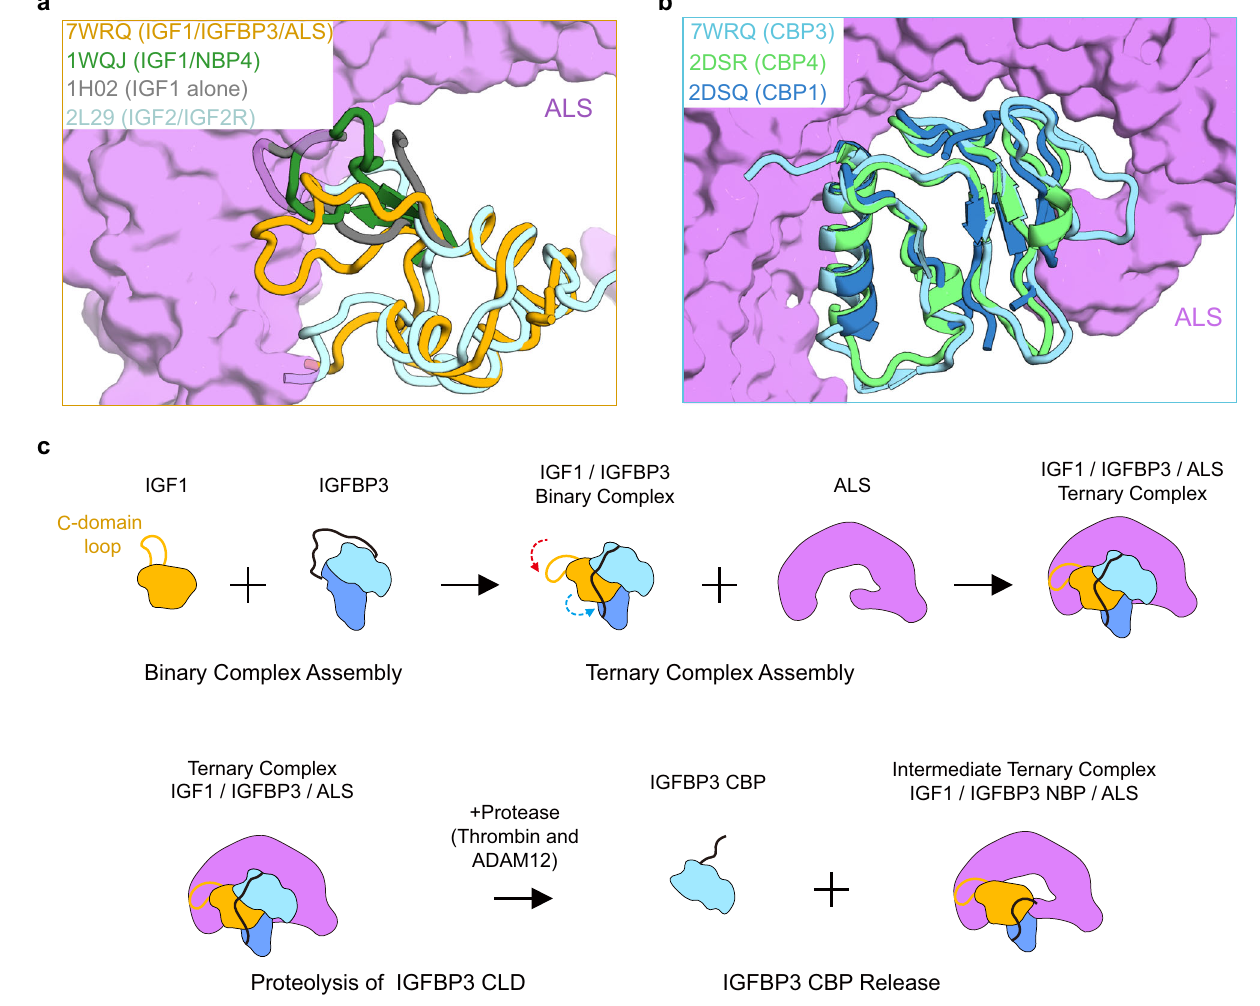
Fig. 7 | Key determinants for speci fi c assembly of the ternary complex and a proposed model for their assembly and disassembly. a Comparison of IGF1 of the IGF1/IGFBP3/ALS ternary complex (yellow) with IGFs in a previously reported structureoffreeIGF1[gray,PDB:1H02 43 ],IGF1/NBP4complex[green,PDB:1WQJ 21 ], and IGF2/IGF2R complex [cyan, PDB: 2L29 66 ]. Structures are shown as tube dia- grams.Forclarity,onlytheCdomainofIGF1inthebinarycomplex(1WQJ)andIGF1 alone (1H02) are presented after superposition of these IGF1 structures. Residues missing in previous structures of IGF1 due to their fl exibility are not shown. The orientation of the view of IGF1and ALSisidentical tothat in Fig.3d. b Comparison